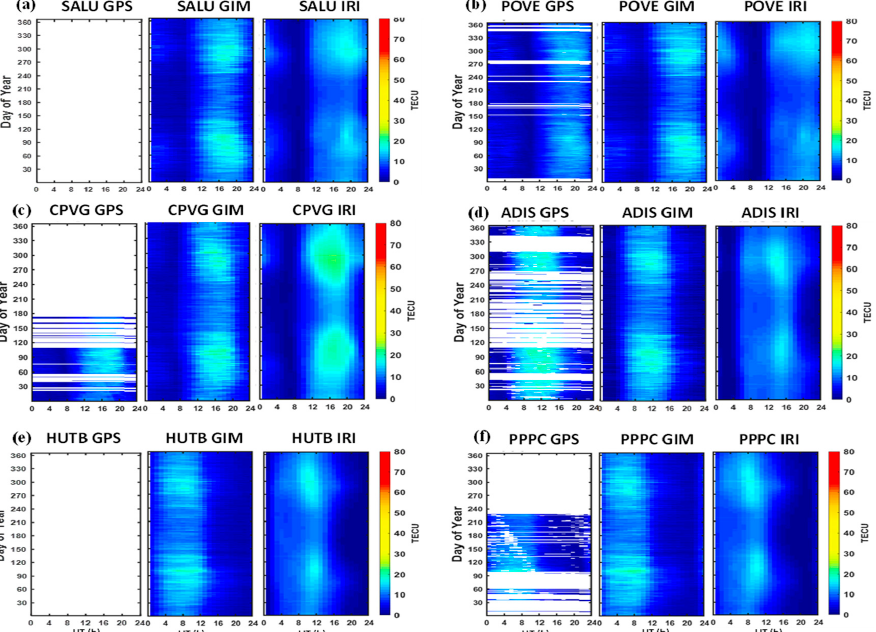
Figure 4. Diurnal variations in GPS-TEC and assessment of GIM and IRI-2016 models at the Amer- ican (GPS stations: ( a ) SALU and ( b ) POVE), African (GPS stations: ( c ) CPVG and ( d ) ADIS), and Asian (GPS stations: ( e ) HUTB and ( f ) PPPC) longitudes for the year 2018. The details of the GPS stations are mentioned in Table 1.